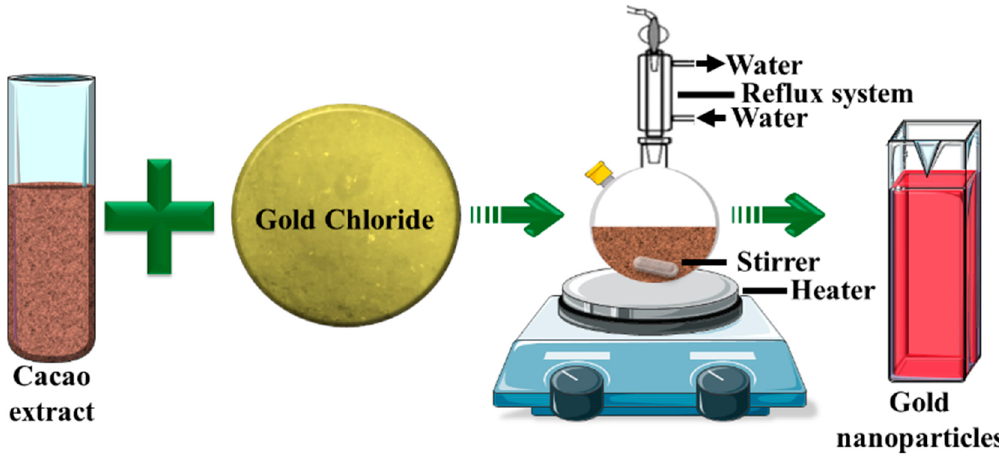
Figure 1. Schematic illustration of gold nanoparticles (AuNPs) synthesis from cacao extract. Nanomaterials 2018 , 8 , x FOR PEER REVIEW